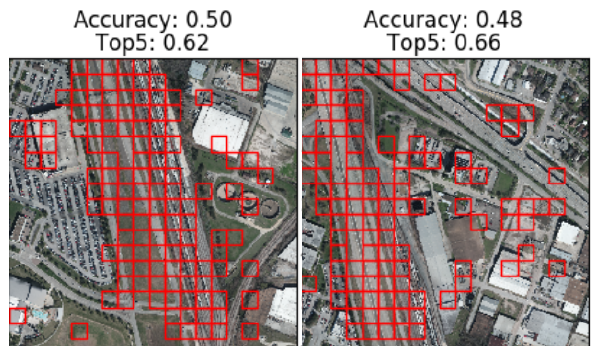
Figure 6. Evaluation on validation